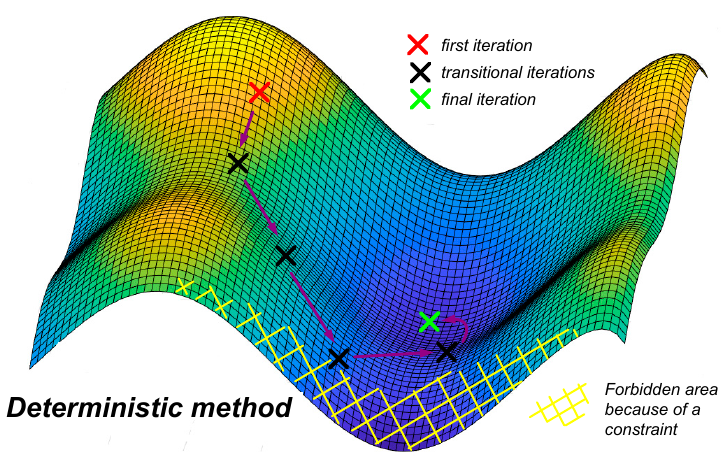
Figure 4. Illustration of optimization with a deterministic algorithm.